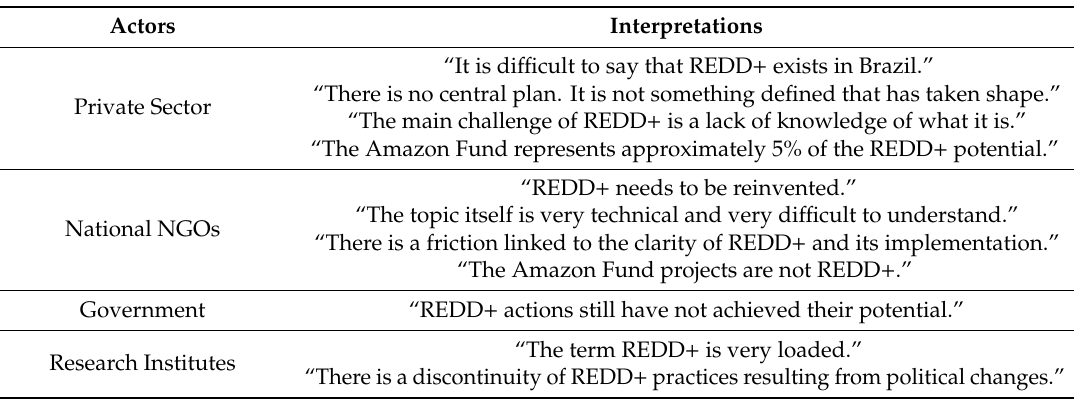
Table 4. Examples of actors’ interpretations of REDD +